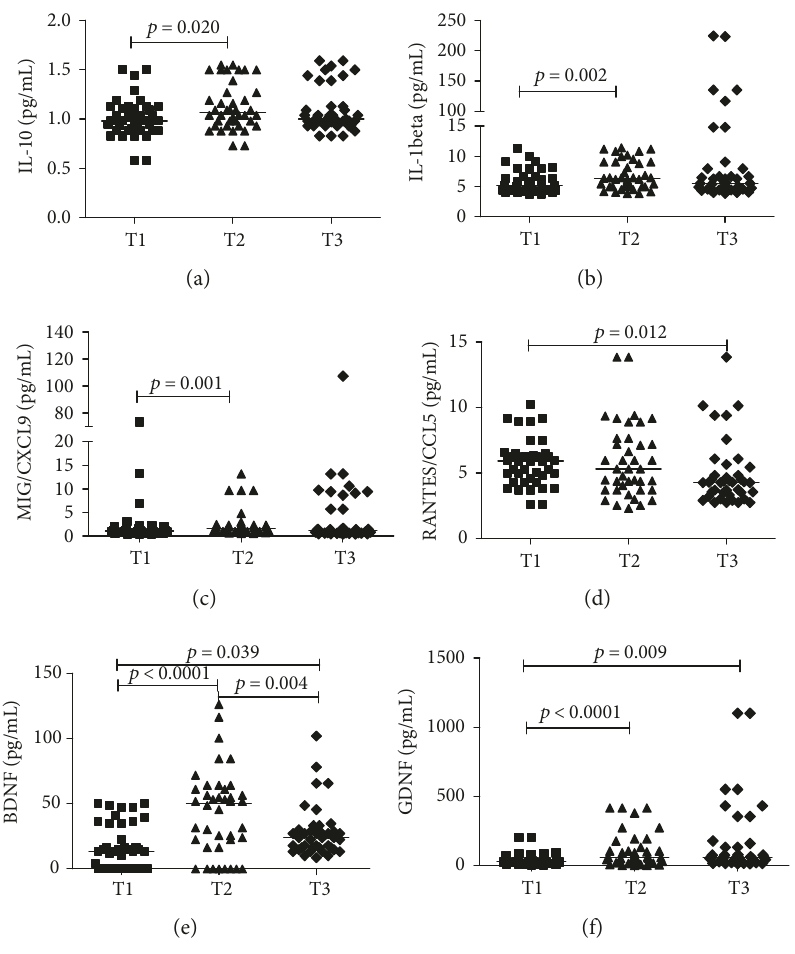
Figure 3: Urinary levels of IL-10, IL1-B, CCL5/RANTES, CXCL9/MIG, CCL5/RANTES, BDNF and GDNF in preterm infants ( N = 40 ) at three di ff erent time points (T1: 48 hours, T2: 72 hours, and T3: 3 weeks after birth). CBA was used in cytokines and chemokines ex vivo analysis, and ELISA for neurotrophic factors. Mann – Whitney test was used for comparisons between medians of patients with normal motor development versus patients of lower than expected motor